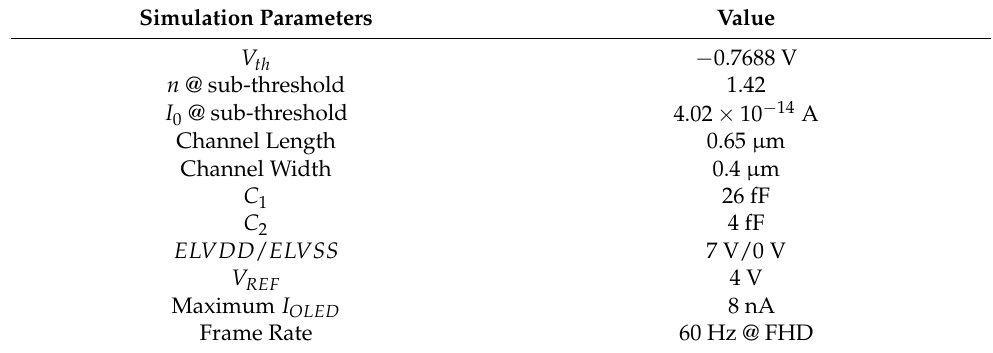
Figure 4. Current and luminance plots of a blue OLED at the sub-pixel area of 3 µ m × 9 µ m. Table 1. Simulation